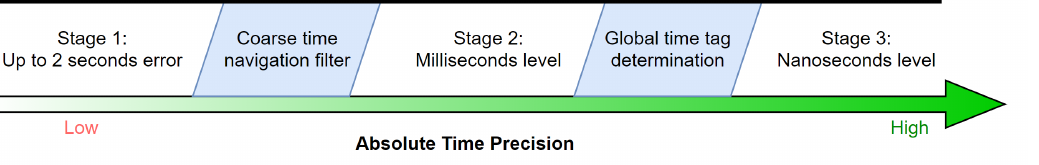
Figure 3. Time precision evolution in the SRTK positioning engine.